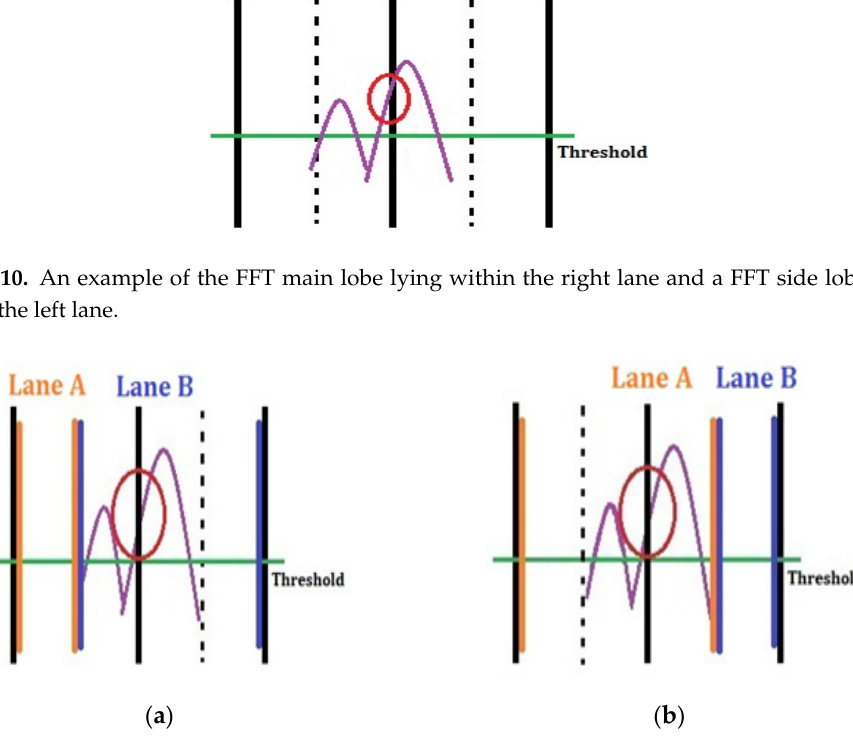
Figure 11. The results of handling the case in Figure 10 using the proposed methods. ( a ) The outcome using the proposed method 2; ( b ) The outcome using the proposed method 1.